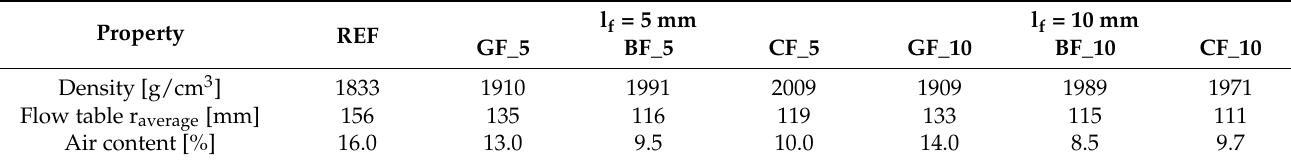
Table 5. Fresh state properties of fibre reinforced